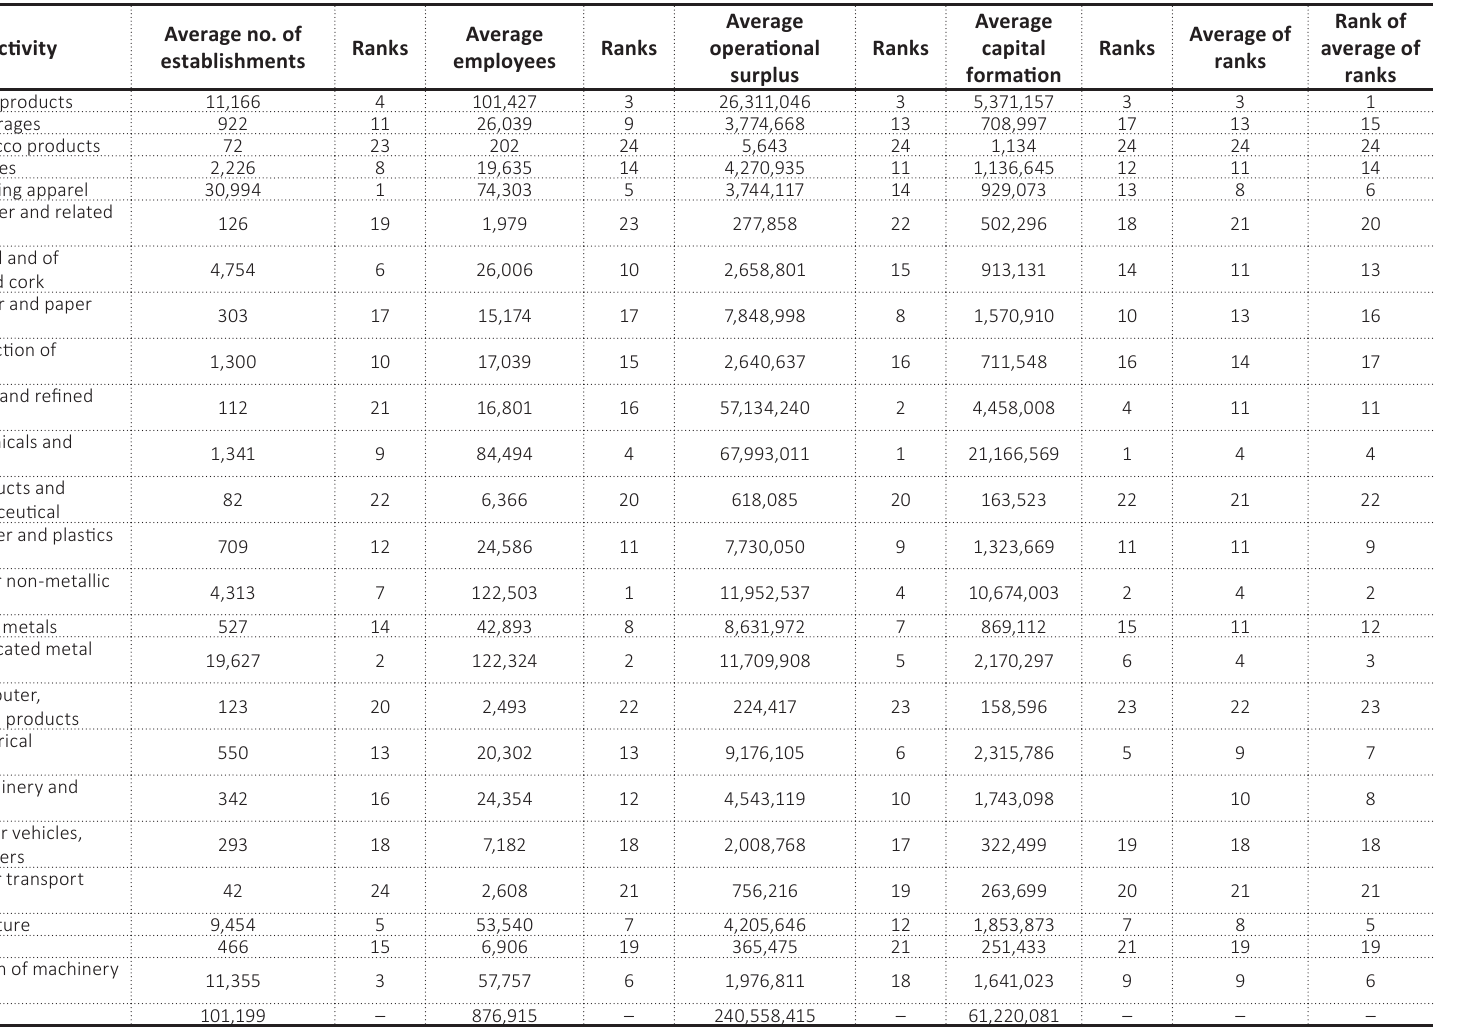
Source: General Authority for Statistics